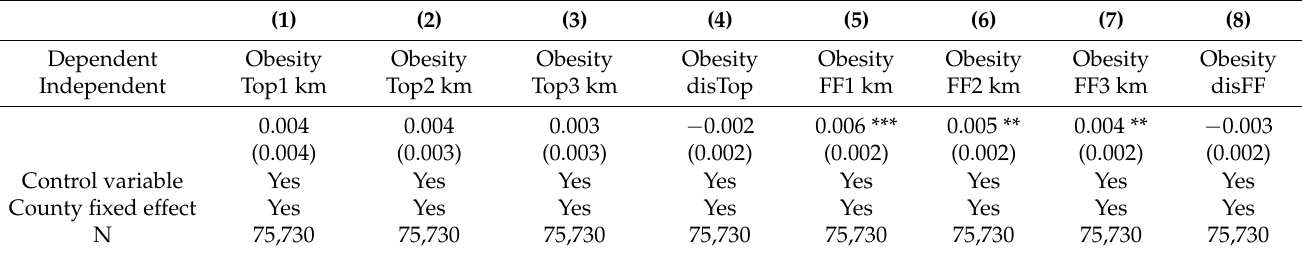
Table 2. Results of OLS.